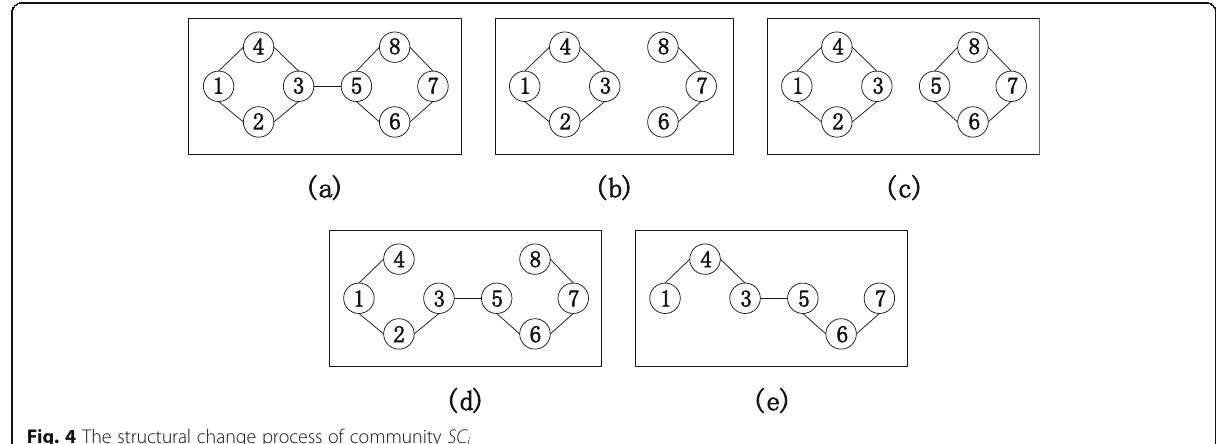
Fig. 4 The structural change process of community SC